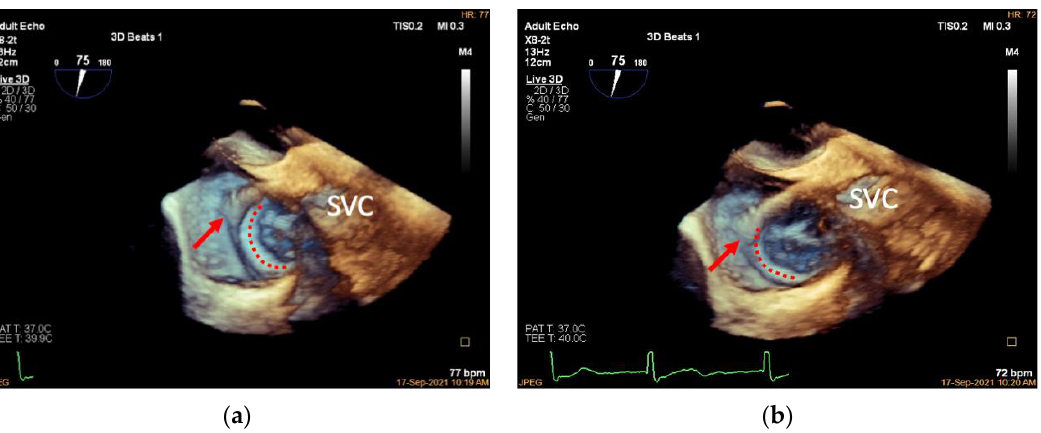
Figure 5. Adjusting the delivery catheter. ( a ): Three-dimensional adjusted mid-esophageal bicaval view (slight clockwise/counterclockwise rotation of the probe from the mid-esophageal bicaval view) demonstrating the head of the delivery catheter (red arrow) pointing into the right atrium above the anteroposterior TA junction (TA shown in red dotted line); ( b ): the same view showing the head of the delivery catheter pointing at the anteroposterior TA junction. SVC, superior vena cava.